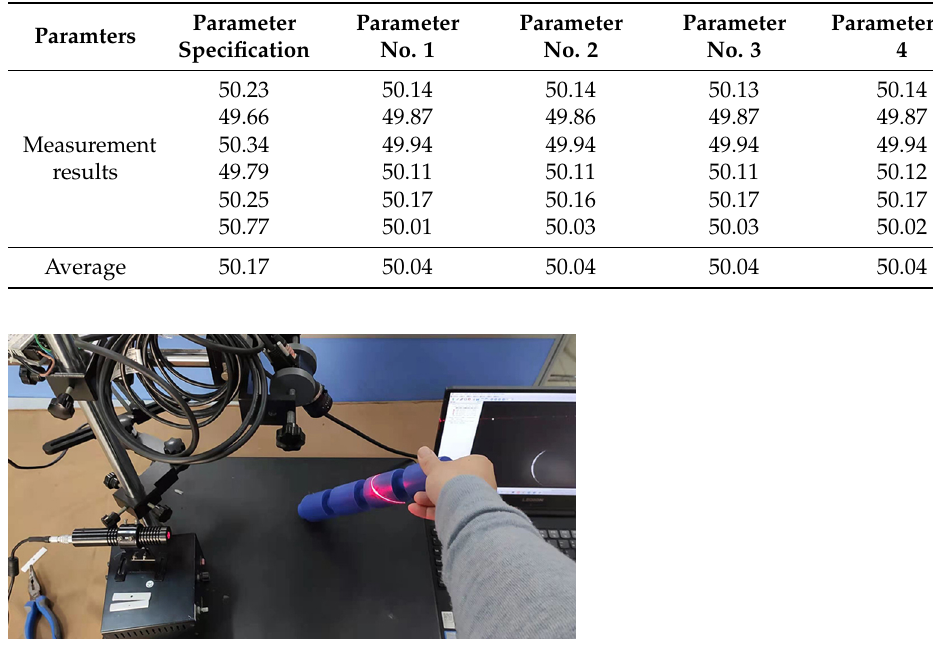
Figure 9. The cylinder measuring